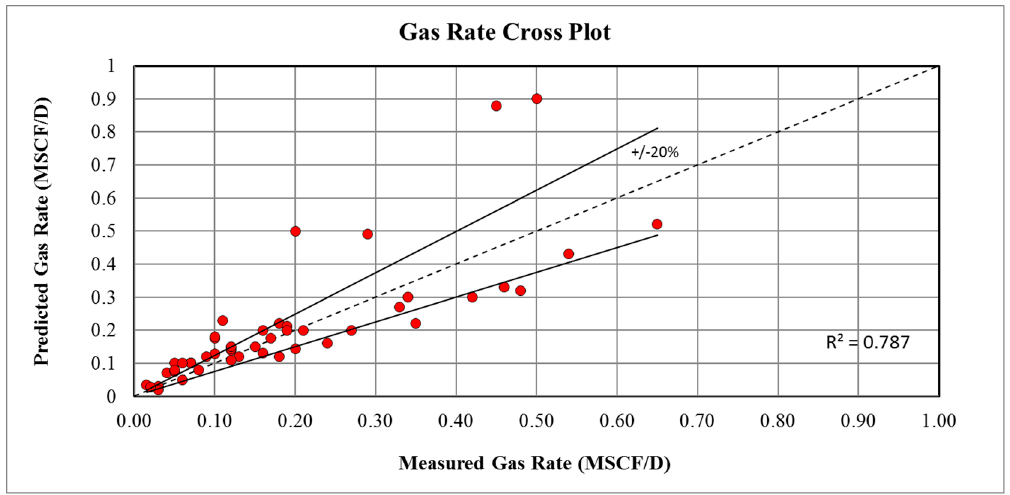
Figure 13. Predicted vs measured gas rate using the Darcy correlation.